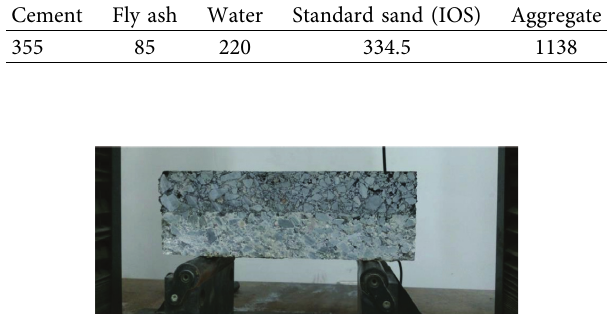
Figure 7: The side view of the concrete block.